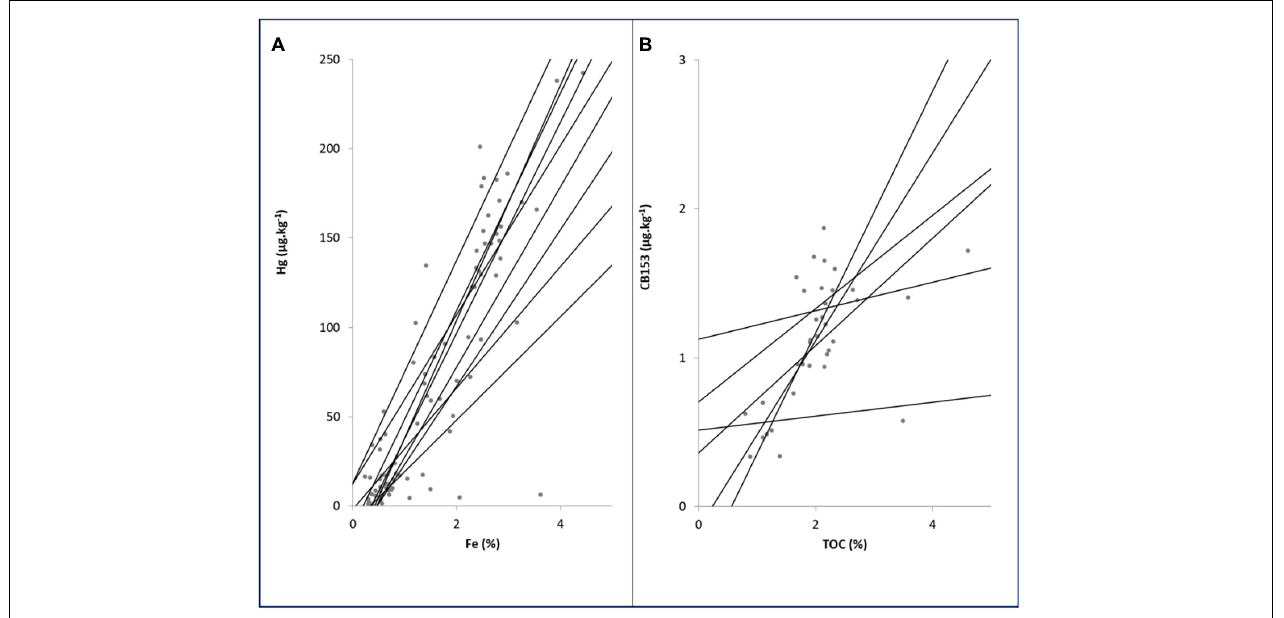
FIGURE 7 | Contaminant—co-factor linear relationships for (A) Hg-Fe and (B) CB153-TOC based on 9 sediment samples collected in March 2015 across the BPNS and fractionated in equally polluted subsamples (9 sediment particle size classes).